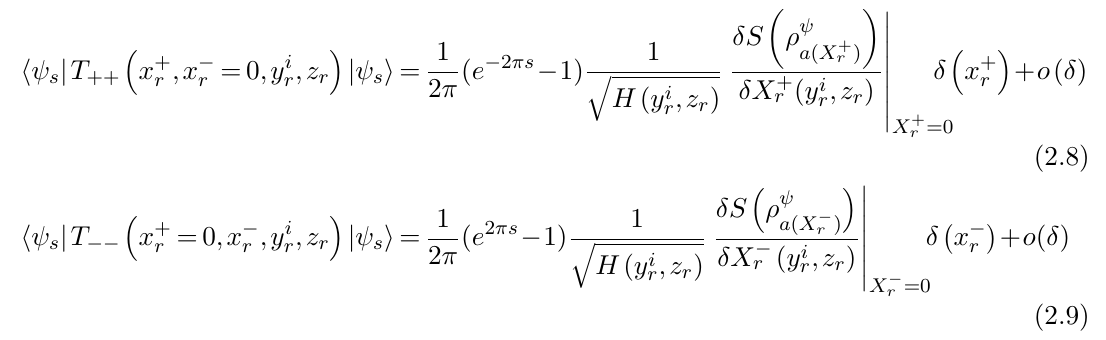
) which is a deformation of a by moving ∂a Figure 3 . The green region marks a ( X + 2 direction along x − = 0 . The ψ states have stress tensor shocks at ∂a proportional to the derivative s 2 of the von Neumann entropy under such shape